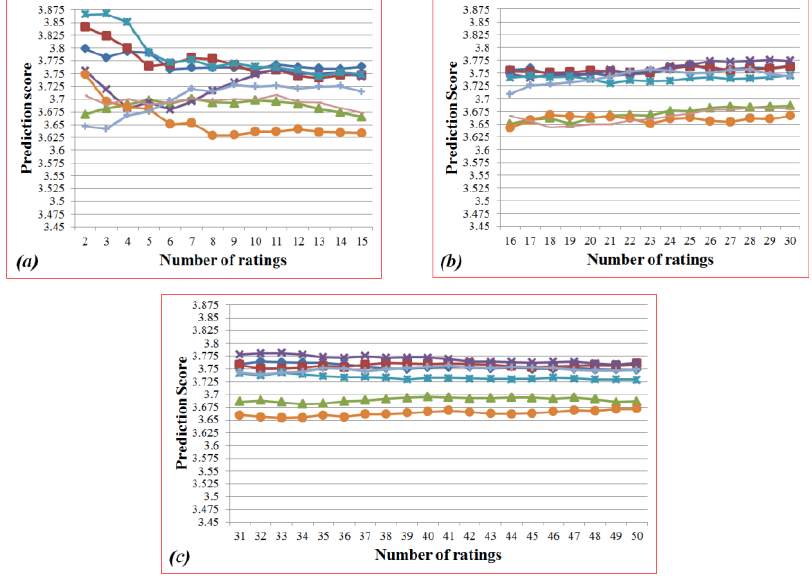
Figure 6. Sub-graphs of Figure 5: ( a ) the ranges from 2 to 15; ( b ) from 16 to 30; ( c ) from 31 to 50.